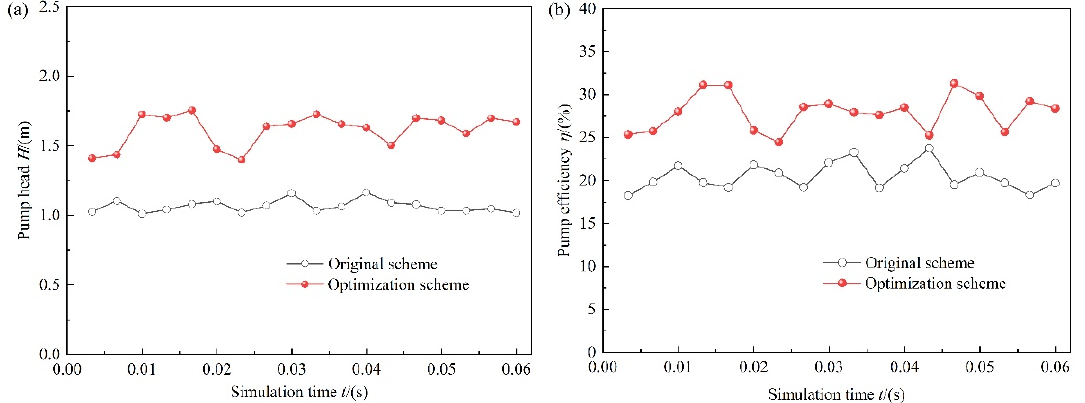
Figure 17. Unsteady hydraulic performance curves of the last three cycles under rated conditions: ( a ) pump head and ( b ) pump efficiency.